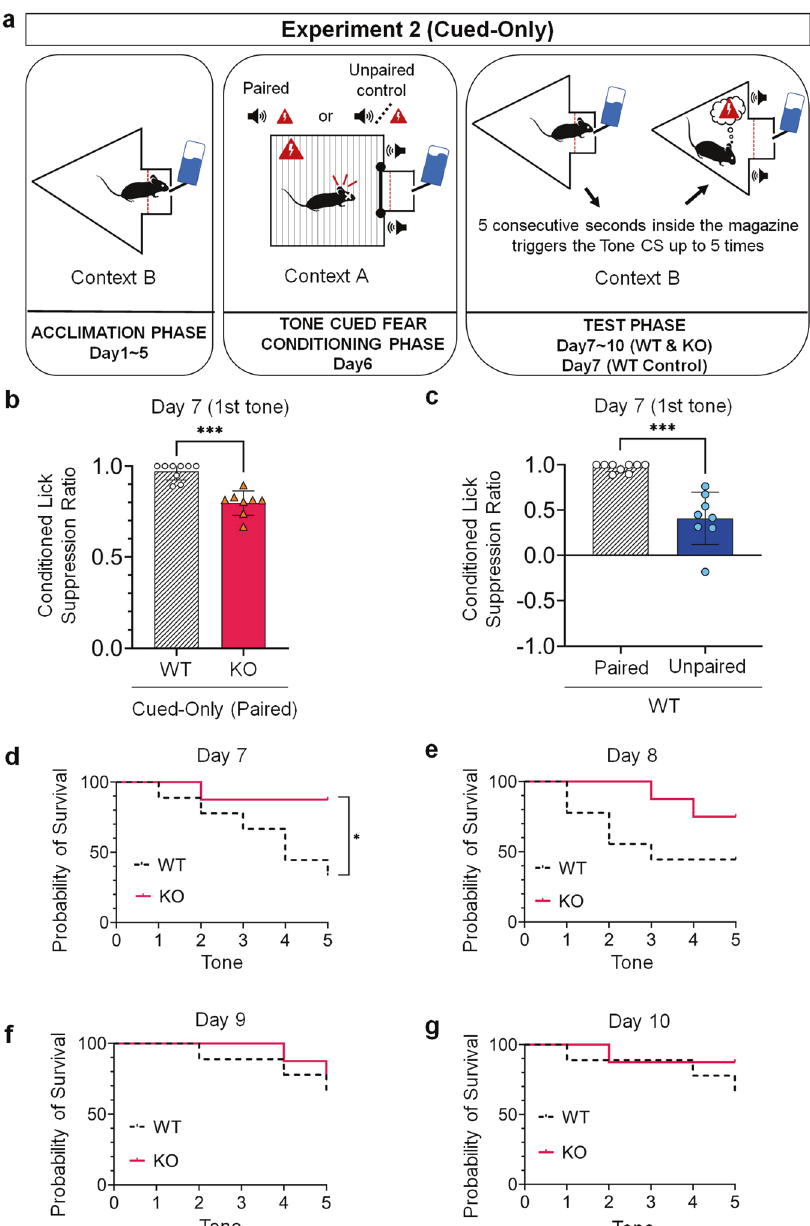
Fig. 3 Cued conditioned lick fear responses. a Schematic drawing of each of the three phases of the cued condition lick suppression task. b Cued conditioned lick suppression performance in WT mice (Cued-Only WT Group; N = 9) compared to KO mice (Cued-Only KO Group; N = 8) during the fi rst tone delivery at Day 7, in a different context (Context B) from that of the conditioning phase (Context A). c Cued conditioned lick suppression performance during the fi rst tone delivery at Day 7 in WT mice that received paired presentations of the tone and footshock during the conditioning phase (Cued-Only WT Group; N = 9) compared to WT mice that received unpaired presentation of the tone and footshock during the conditioning phase (Cued-Only WT Control Group; N = 8). Both groups where conditioned in Context A and tested in Context B. Two-tailed t-test for independent samples with a Bonferroni correction. Data are represented as means and error bars represent ±SEM. Asterisks indicate P -values (*** P < 0.001). d – g Percentage probability of survival rate between WT (Cued-Only WT Group; N = 9) and KO mice (Cued-Only KO Group; N = 8) tested from Day 7 to Day 10. Log-rank (Mantel-Cox) tests. Asterisks indicate P -values (* P <